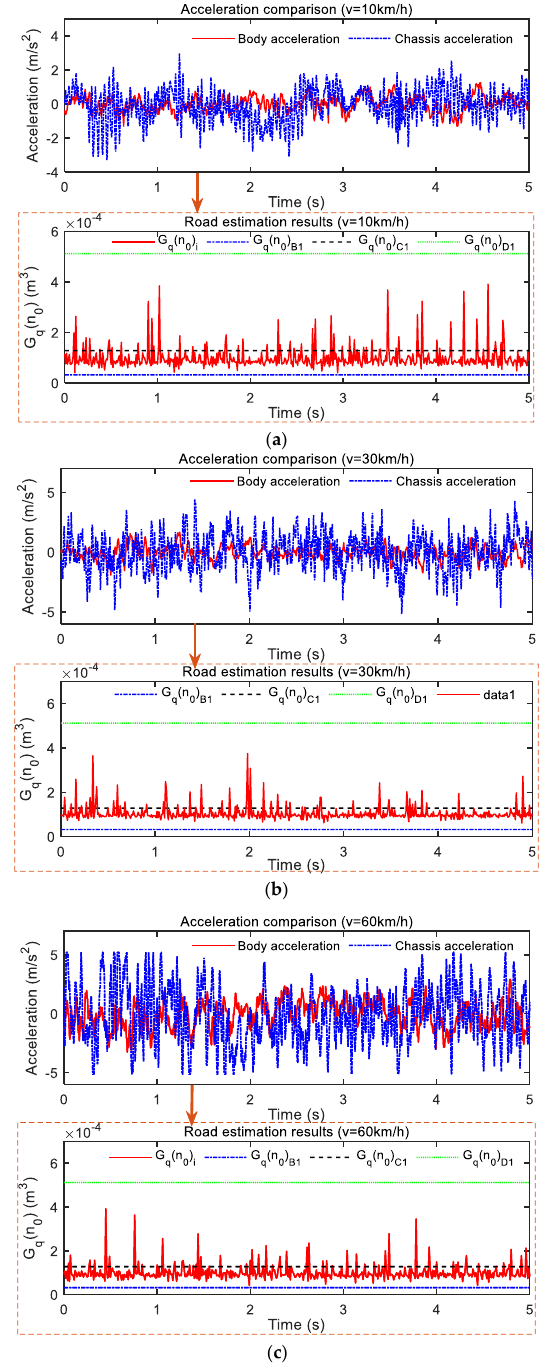
Figure 12. Comparison of road estimation under three speeds in road section 1. ( a ) Comparison of results when v = 10 km/h. ( b ) Comparison of results when v = 30 km/h. ( c ) Comparison of results when v = 60 km/h.